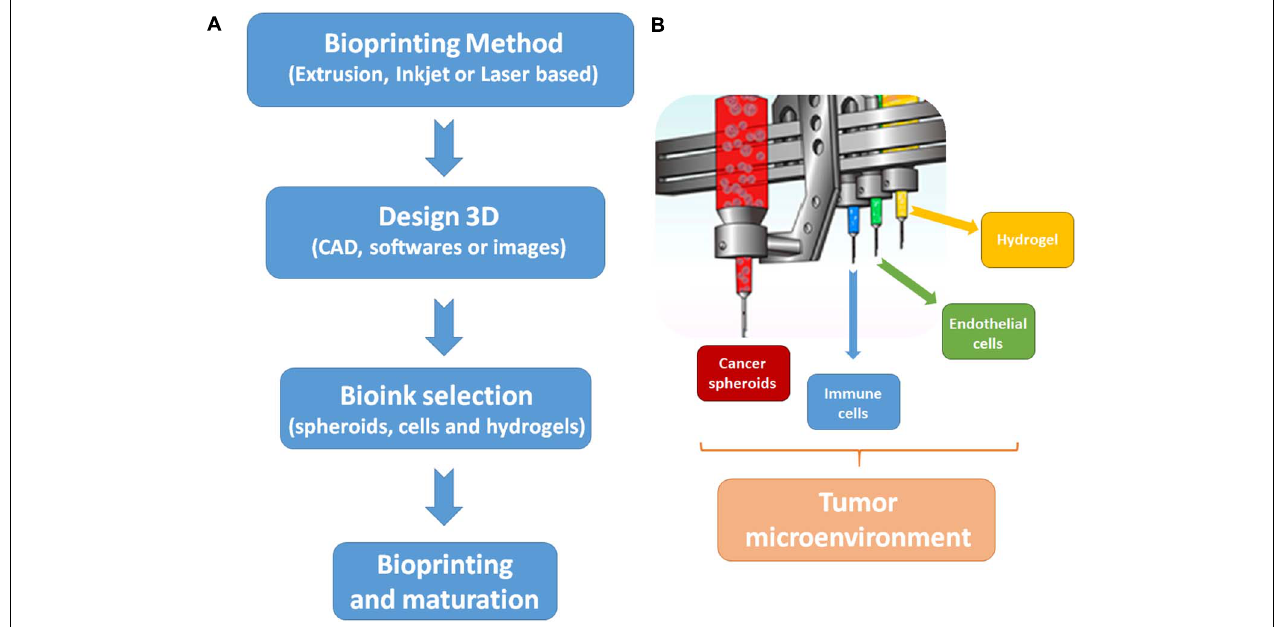
FIGURE 2 | Steps and bioinks to biofabricate the tumor microenvironment by 3D bioprinting. (A) Steps to start the biofabrication process. First, it is necessary to choose a bioprinting method, which will complement the desired output. The majority of studies to develop cancer models are done with extrusion-base techniques. Then, the 3D design of the cancer model must be made by software or can be based on images. Next, it is necessary to choose the biological (cells or spheroids) and biomaterial (usually hydrogels) components of the bioinks. Finally, the bioprinting process can be started and tissue maturation can be carried out post printing. (B) Bioinks to replicate tumor microenvironments. In order to mimic the tumor microenvironment, the main bioinks are tumor spheroids, immune cells, endothelial cells, and a hydrogel to support cells proliferation and survival.